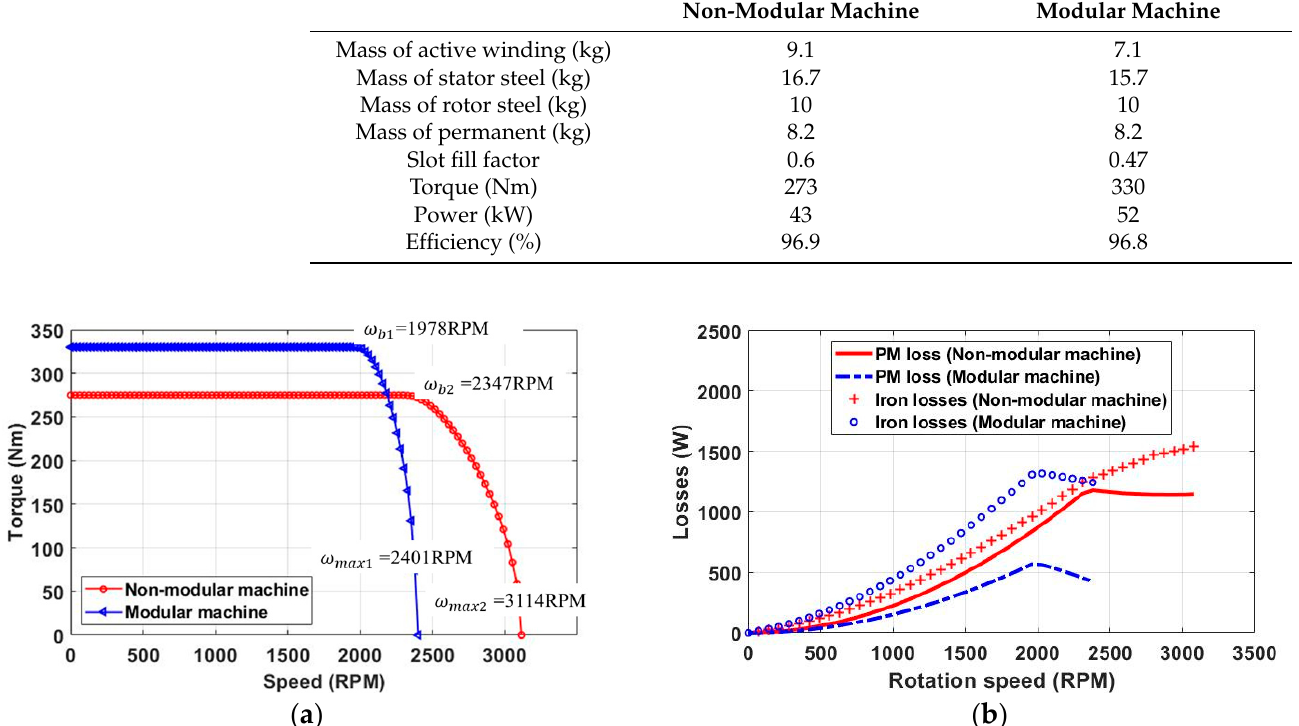
Figure 3. ( a ) Torque and ( b ) losses vs. speed for the modular and non-modular machines.